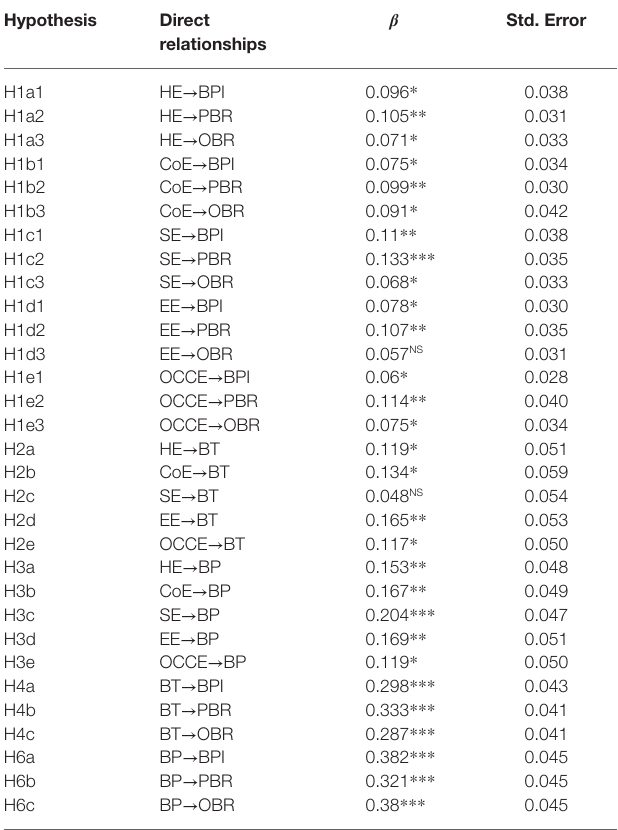
TABLE 4 | Hypotheses testing direct effect. Hypothesis Direct